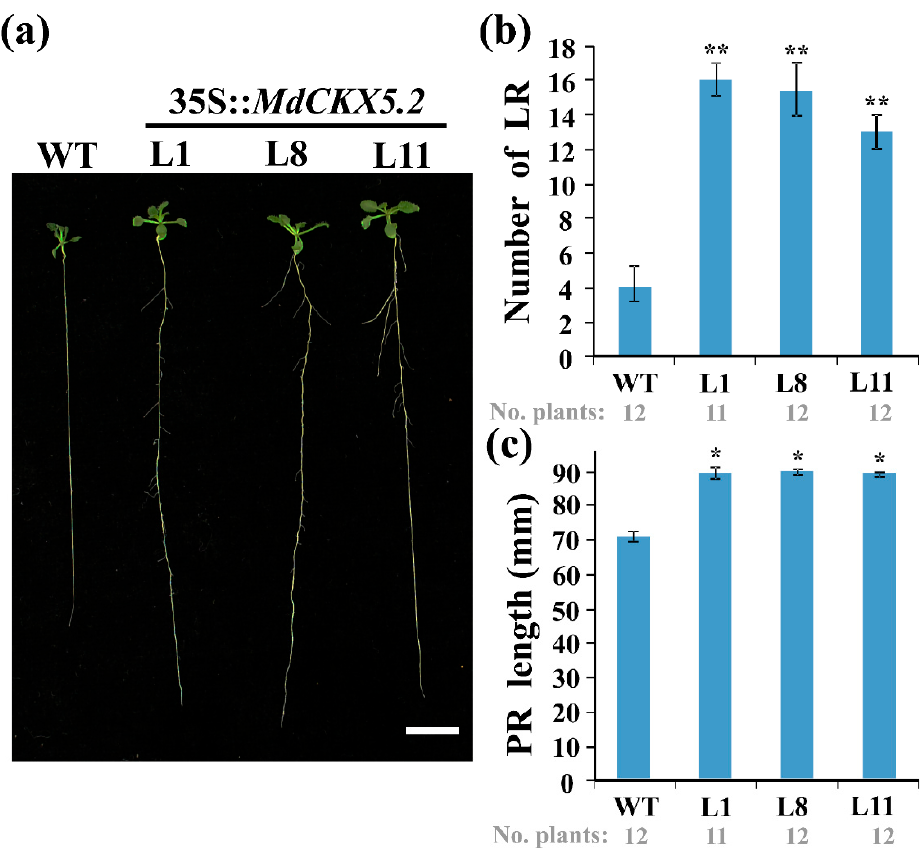
Figure 3. Ectopic expression of MdCKX5.2 promotes root development in Arabidopsis . ( a ) Morpho- logical characteristics of transgenic Arabidopsis . Three individuals homozygous T3 lines (L1, L8, and L11) and the wild-type (WT) plants were grown on MS media for 12 days. ( b , c ) Numbers of visible lateral root (LR) and lengths of primary root (PR) in the MdCKX5.2 -overexpressing and WT plants on MS medium. The gray numbers under the charts indicate the number of plants measured (No. plants). Error bars, ±SD. Significant differences were detected by t -test: * p < 0.05 and ** p < 0.01. Bars = 1 cm.